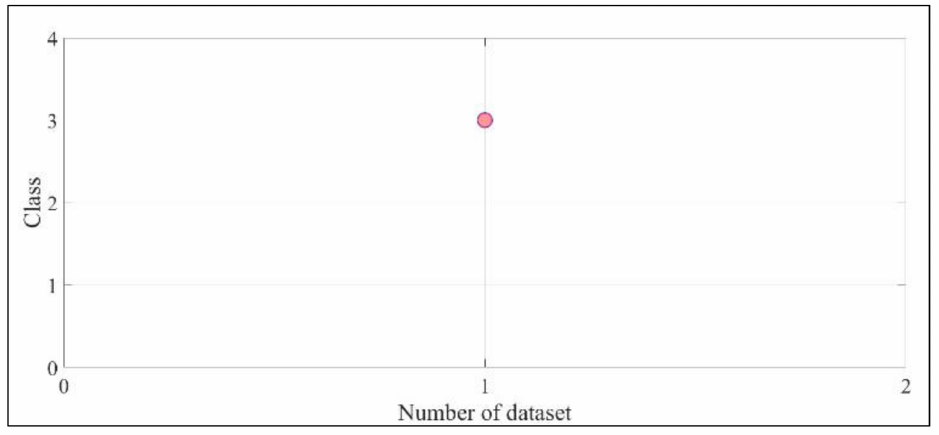
Figure 12. The SOH diagnosis result of pattern